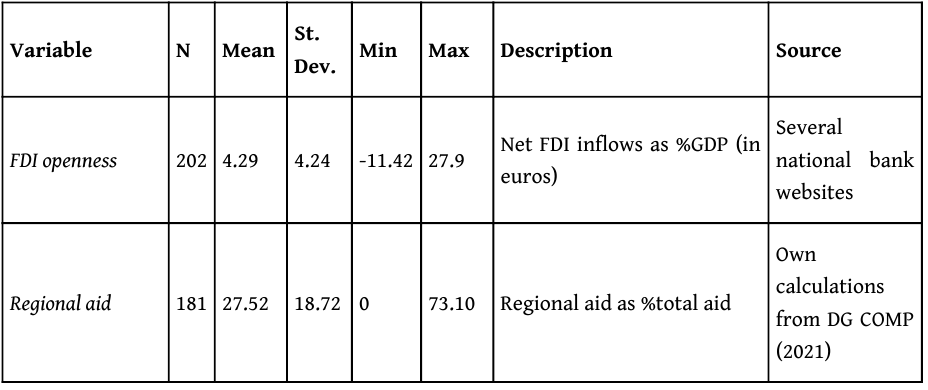
Table 1: Descriptive statistics and sources